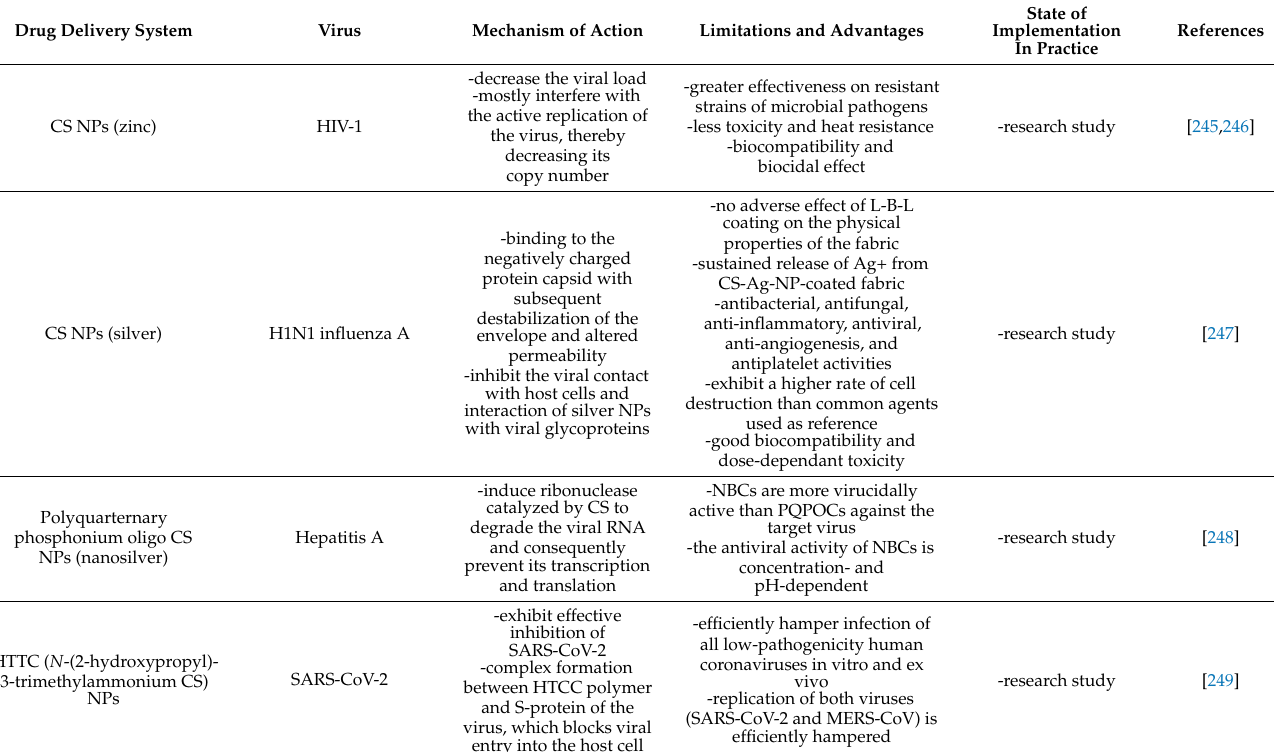
Figure 11. Different types of CS NPs in antiviral drug delivery systems. Table 3. CS NPs in drug delivery systems of